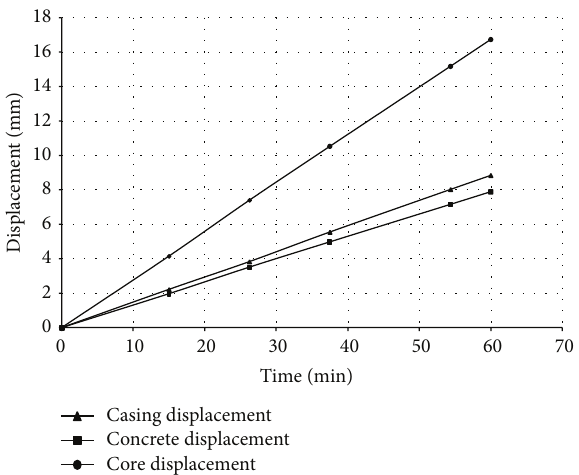
Figure 5: Axial displacement comparison in BRB